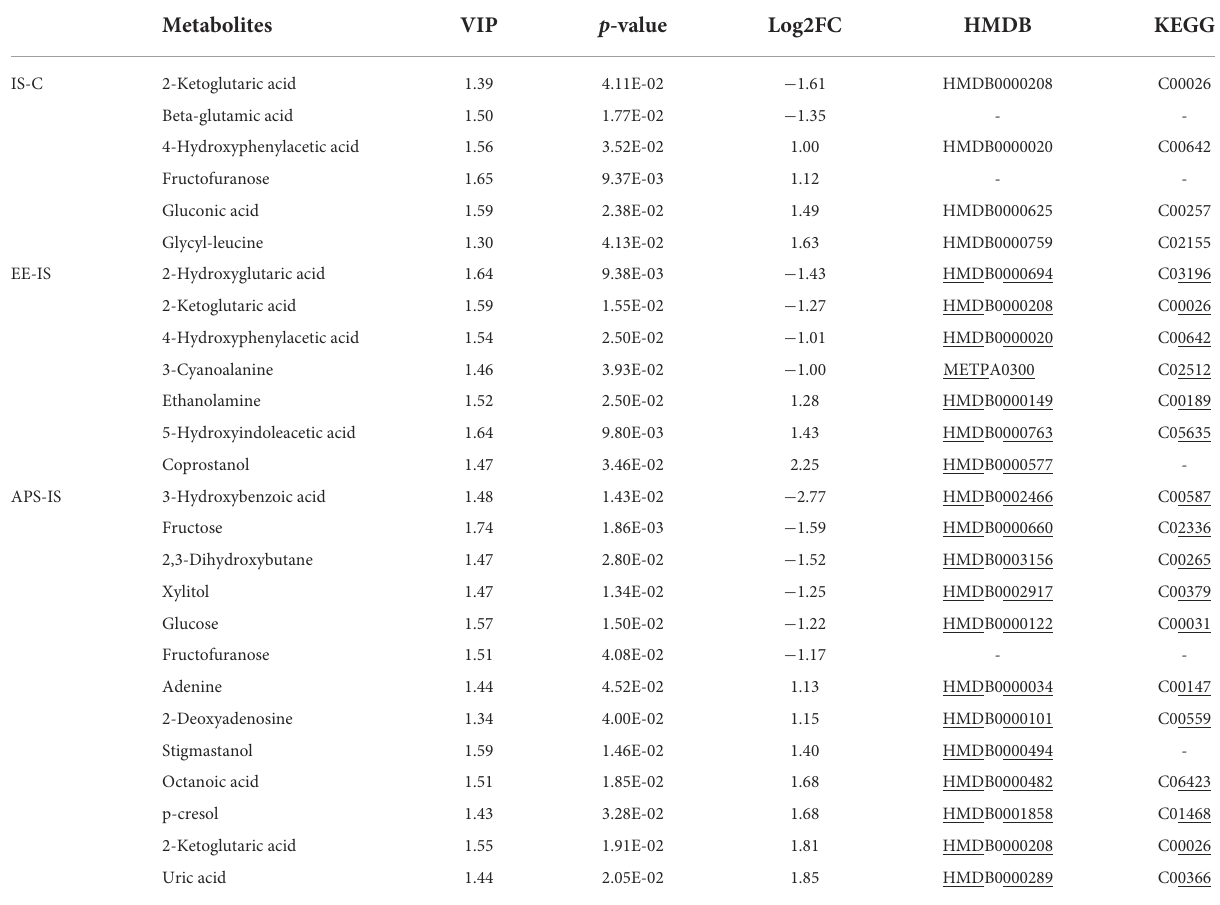
TABLE 3 Differential metabolites of intestinal contents in each group at 14 days (|Log[2]FC| ≥ 1). Metabolites VIP p -value Log2FC HMDB KEGG